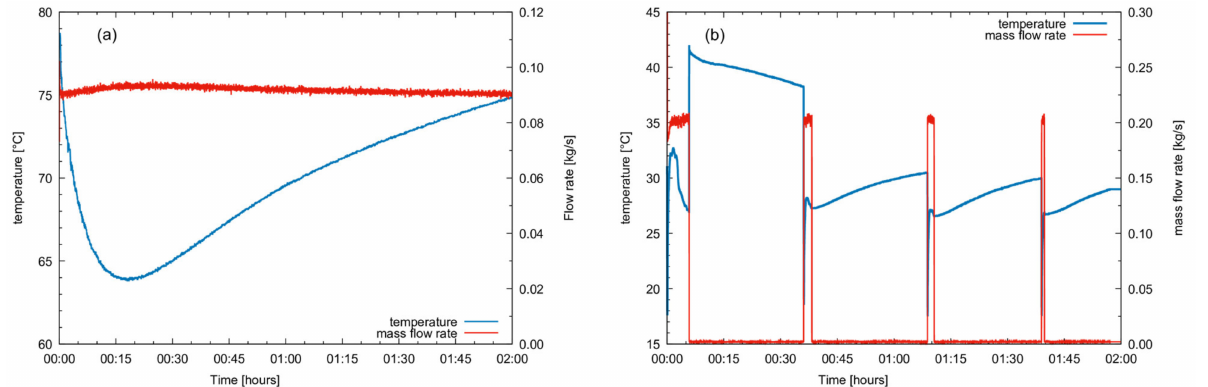
Figure 11. Boundary conditions for numerical simulation, inlet temperature and mass flow rate ( a ) Test 1—charge, ( b ) Test 2—discharge.